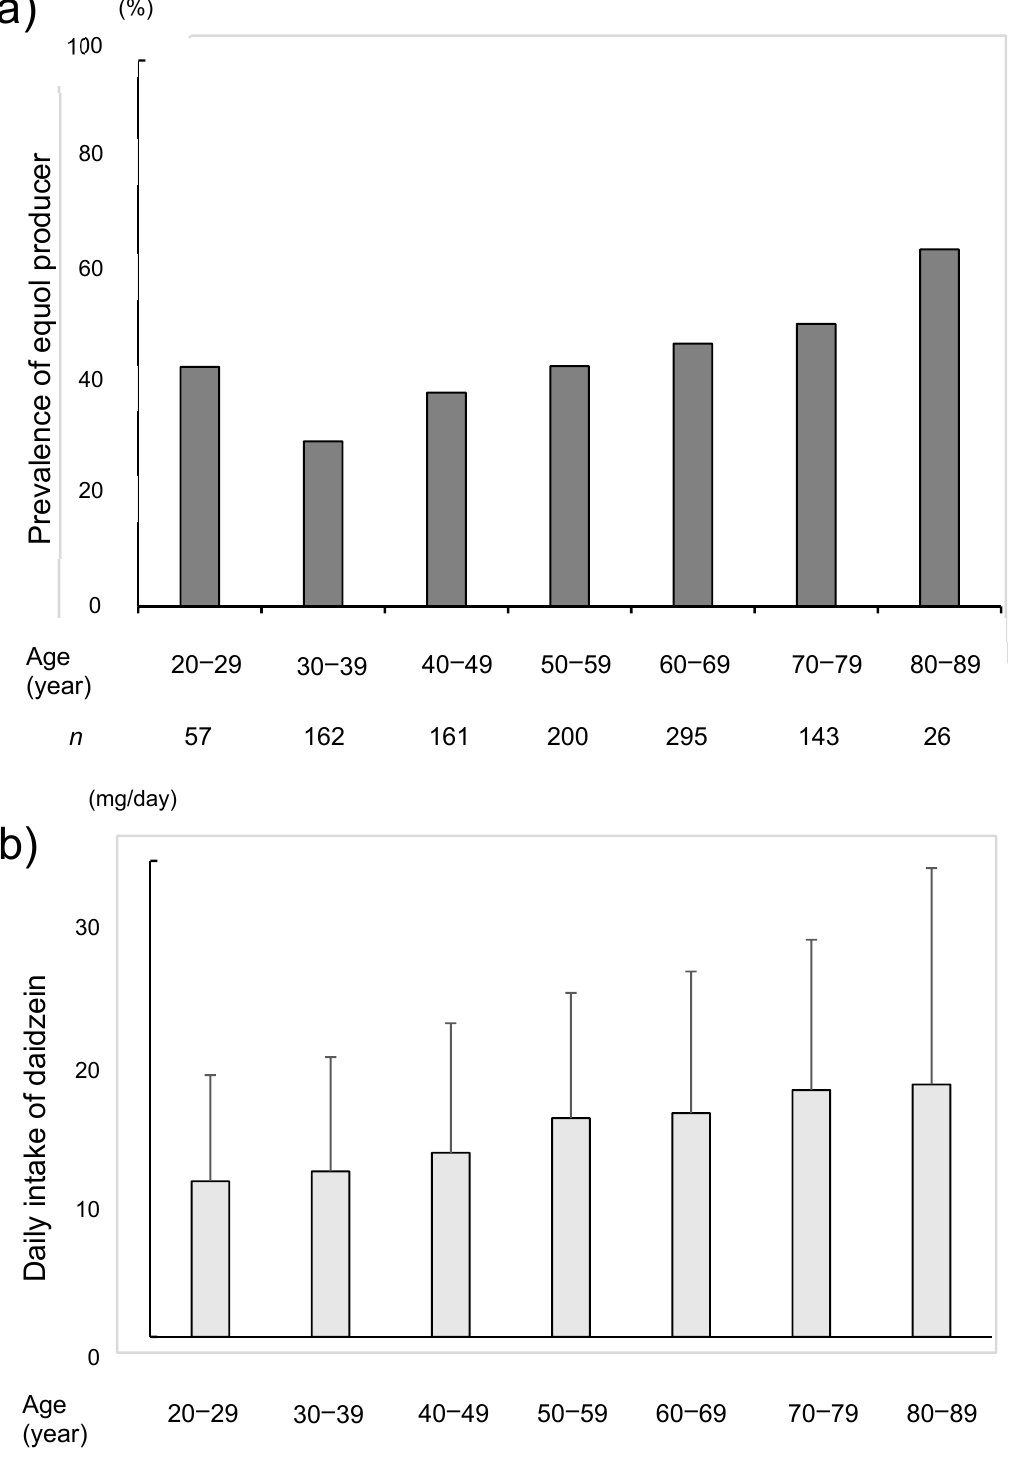
Figure 5. The rate of equol producer ( a ) and the daily intake of daidzein ( b ) among the seven age groups and by decades.